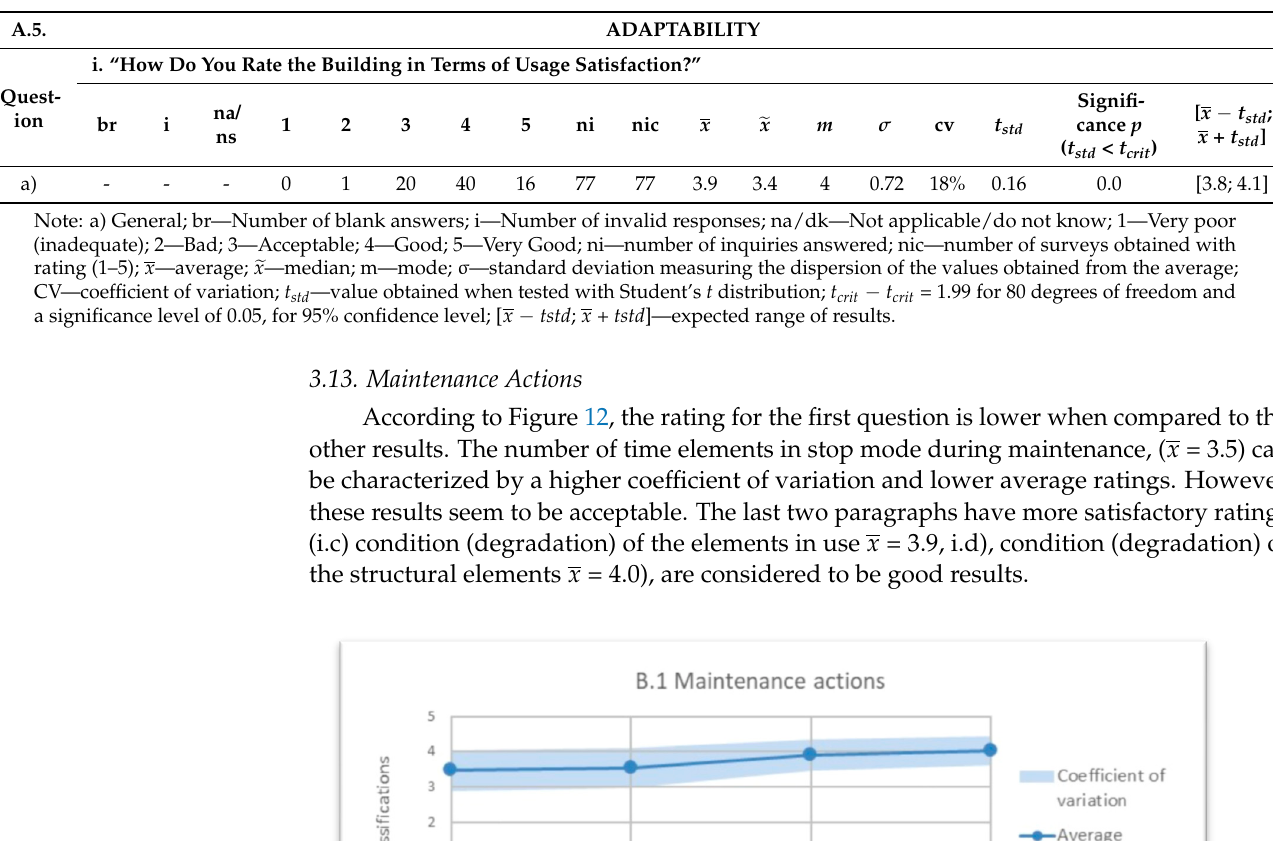
Table 3. Average ratings of adaptability.